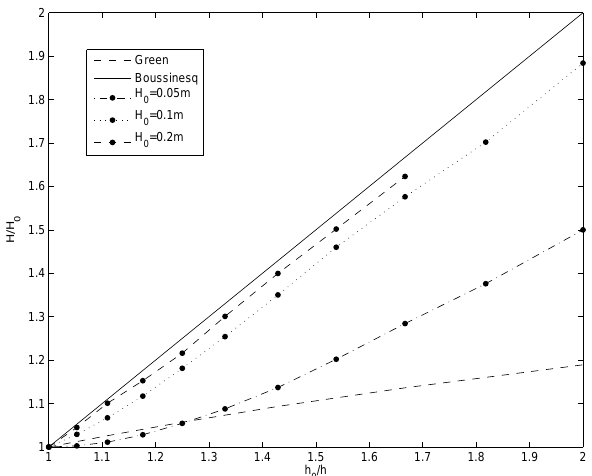
Fig. 3. Computations for the shoaling of solitary waves using the method of Pelinovsky and Talipova (1977, 1979), and using numerical data found by Longuet-Higgins (1974); Longuet-Higgins and Fenton (1974). The solid line depicts the shoaling relation according to Boussinesq’s law. The lower dashed line depicts the shoaling relation according to Green’s law. Shoaling rates for waves of initial waveheight H 0 = 0 . 05m, 0 . 1m and 0 . 2m are computed. The dashed curve terminates because the maximum wave energy is